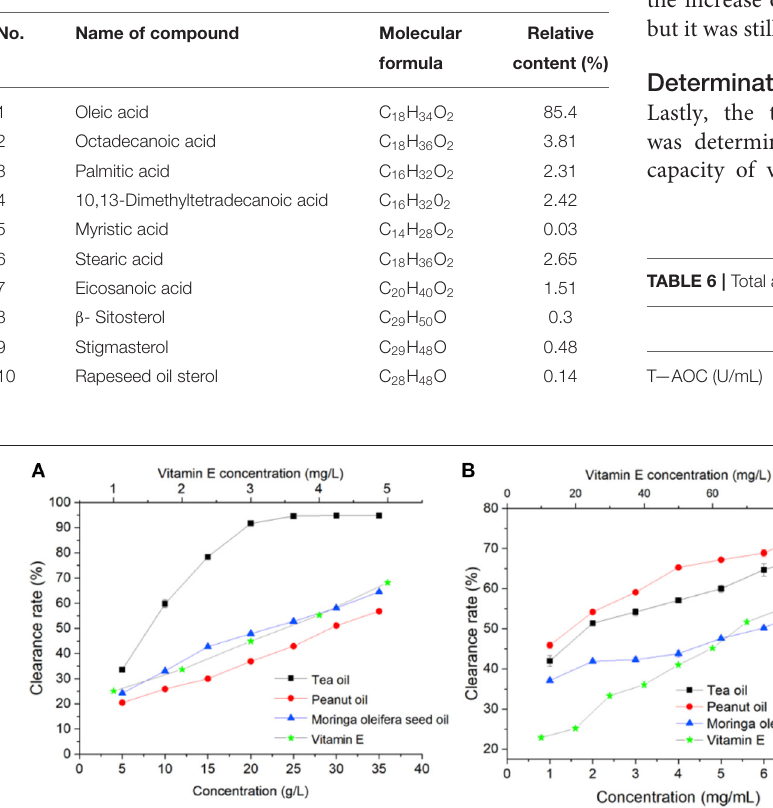
Frontiers in Nutrition |